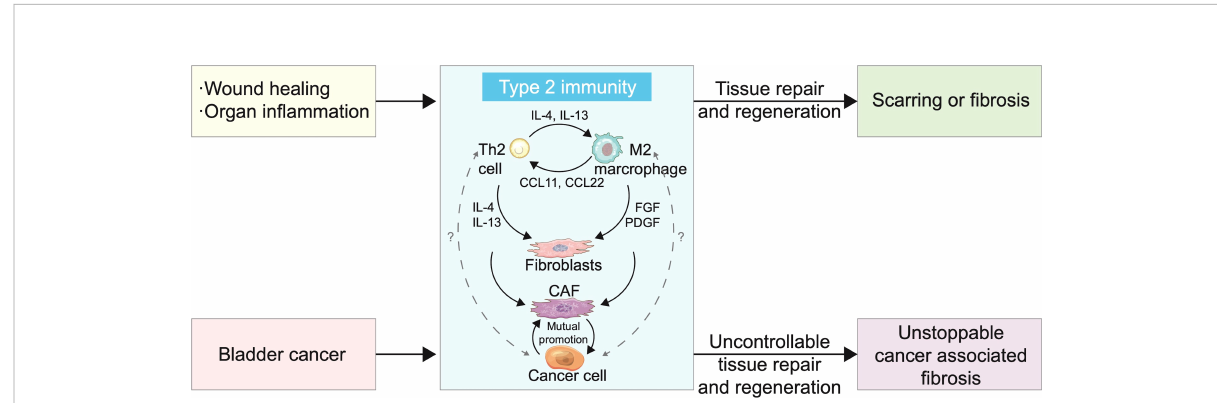
FIGURE 3 Type 2 immunity and bladder cancer (BC) cells cause rapid and persistent progression of cancer-associated fi brosis. Scarring or fi brosis caused by wound healing or in fl ammation of organs is associated with overactivation of type 2 immunity. T helper 2 (Th2) cells and M2 polarized macrophages promote mutual differentiation and jointly recruit fi broblasts. The proportion of M2 cells and cancer-associated fi broblasts (CAFs) in BC increased with tumour progression and interleukin (IL)-13 level increased signi fi cantly in tumours, which suggests that BC was closely related to type 2 immunity. CAFs have shown signal crosstalk with cancer cells in a variety of cancers, promoting differentiation, proliferation, and metastasis. Cancer cell involvement makes type 2 immunity persistent and uncontrollable, resulting in tumour